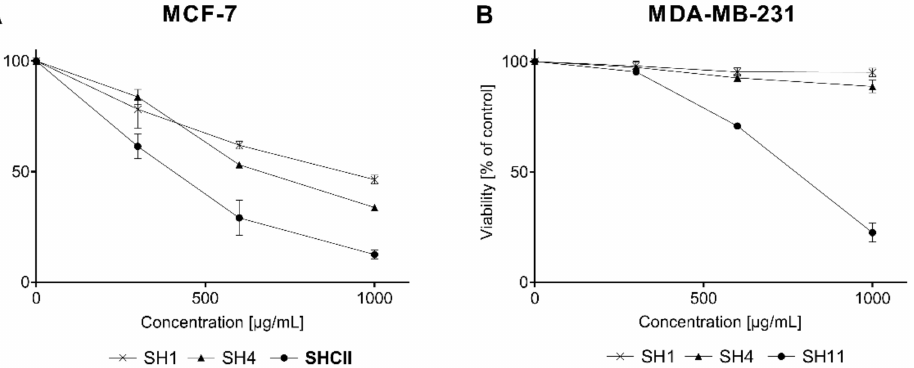
Figure 2. The influence of SH1 , SH4 , and SH11 on the viability of MCF-7 ( A ) and MDA-MB- 231 ( B ) cell lines after 24 h of incubation with increasing concentrations of the given extract and fractions (300–1000 µ g/mL). Values are presented as mean ± SD from three independent experiments performed in duplicate.